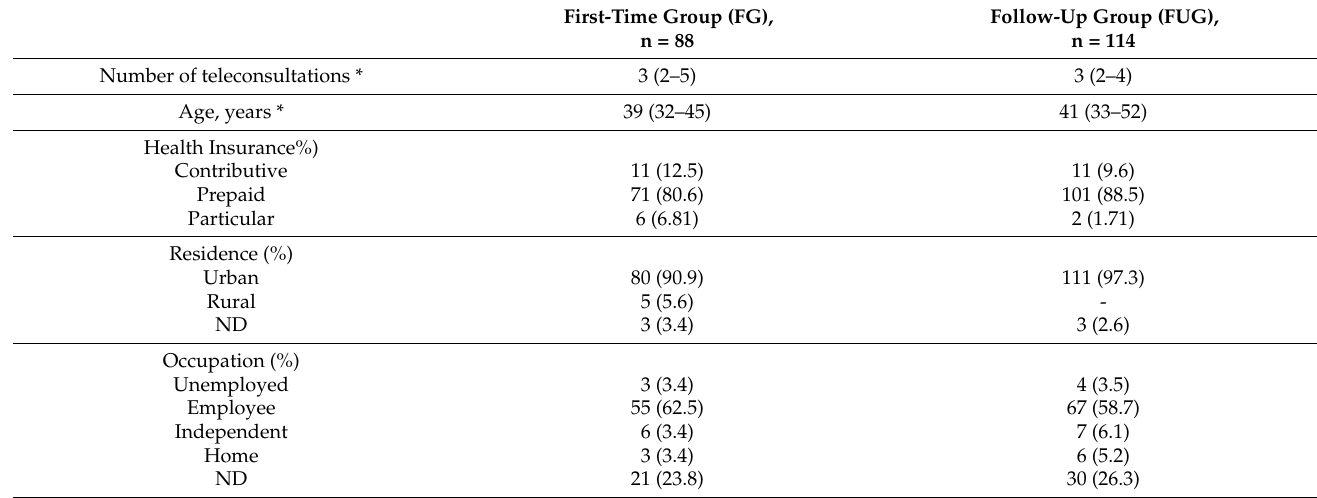
Table 1. Sociodemographic and clinical characteristics.